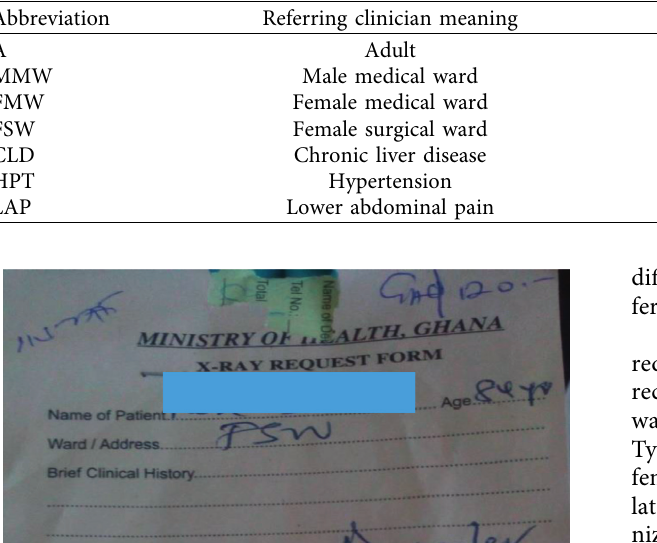
Table 1: Abbreviations on request forms that are not internationally recognized,